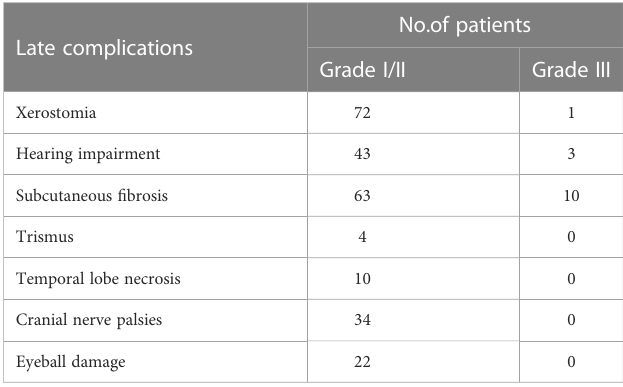
TABLE 5 Late radiation related toxicities of 139